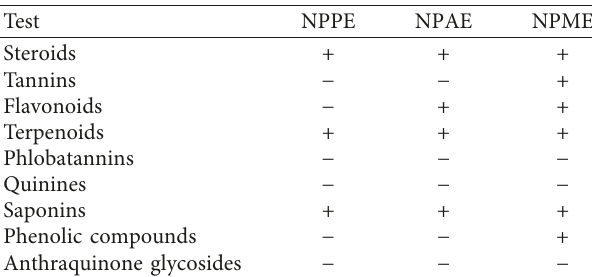
Table 2: Qualitative tests for phytochemical screening of Nonea